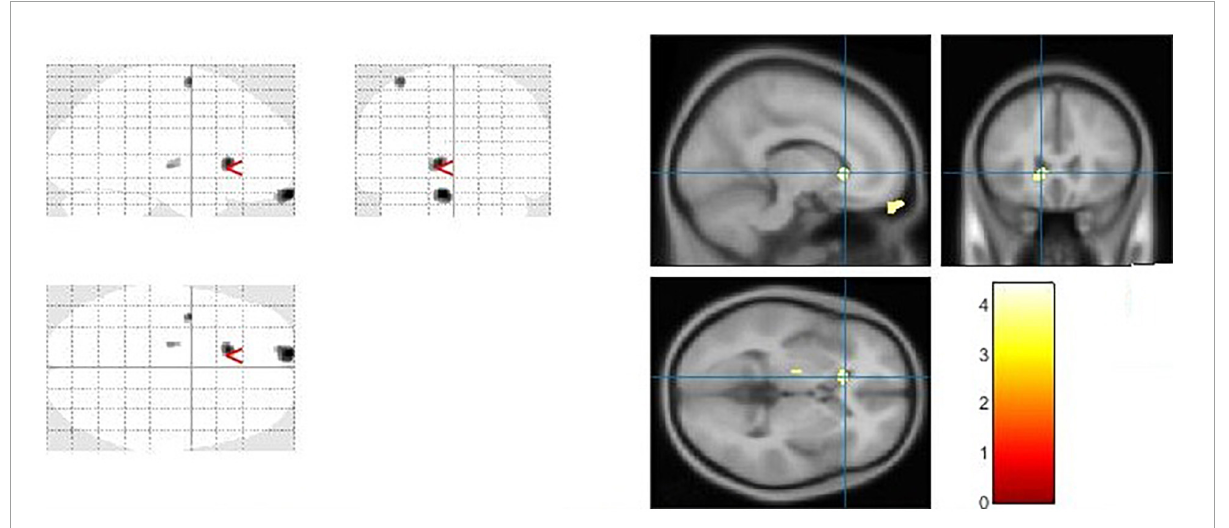
FIGURE4 The significant cerebrospinal fluid (CSF) alterations by VBM analyses with the covariate of no interest (TIV) in the left caudate when PD > controls with p < 0.05 and extent threshold K =